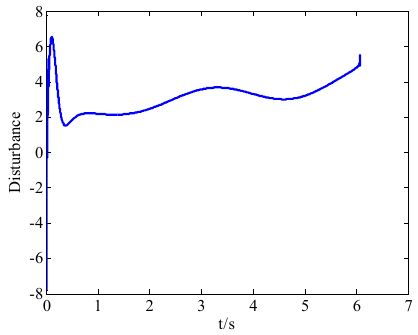
Figure 15. Total disturbance estimated by RBFNN.